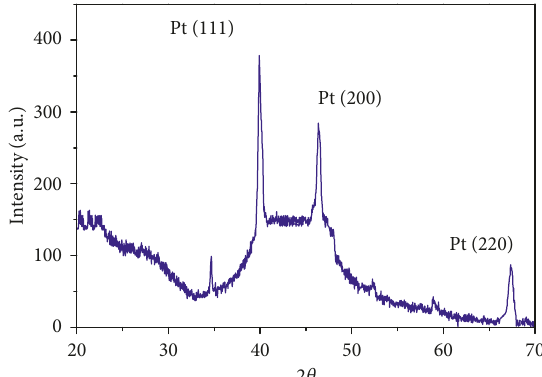
Figure 3: The X-ray diffraction pattern of platinum nanoparticles showing the face-centered cubic (fcc) crystal structure.